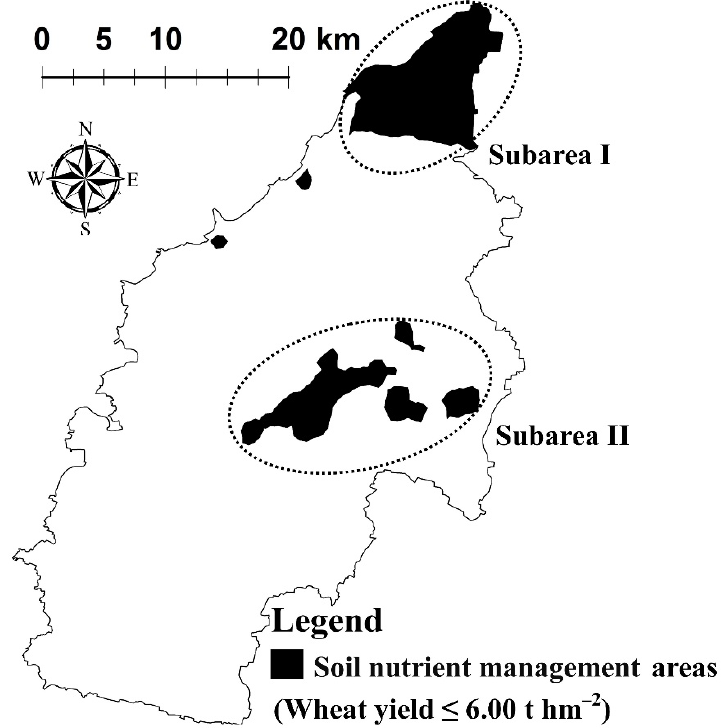
Figure 4. Soil nutrient management areas delineated based on the spatial distribution patterns of wheat yield predicted by robust